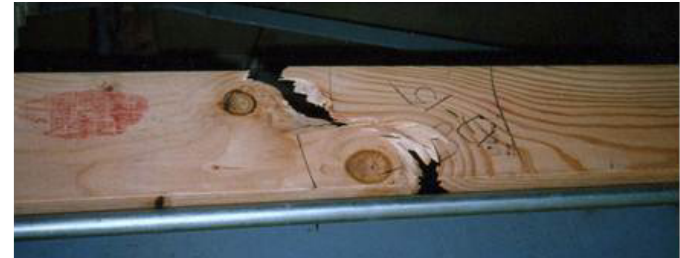
Figure 3. Failure under loading often occurs where edge knots or grain deviation around knots is